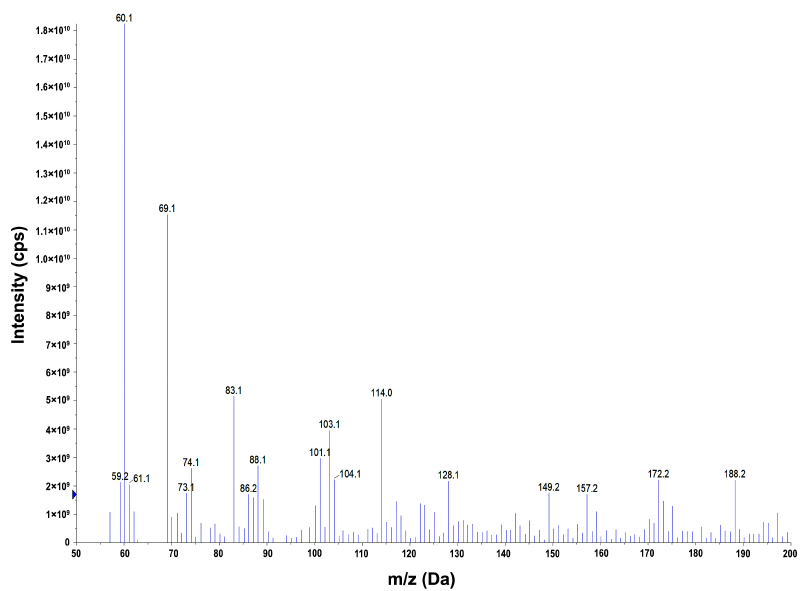
Figure 12. Mass spectrum of metronidazole products